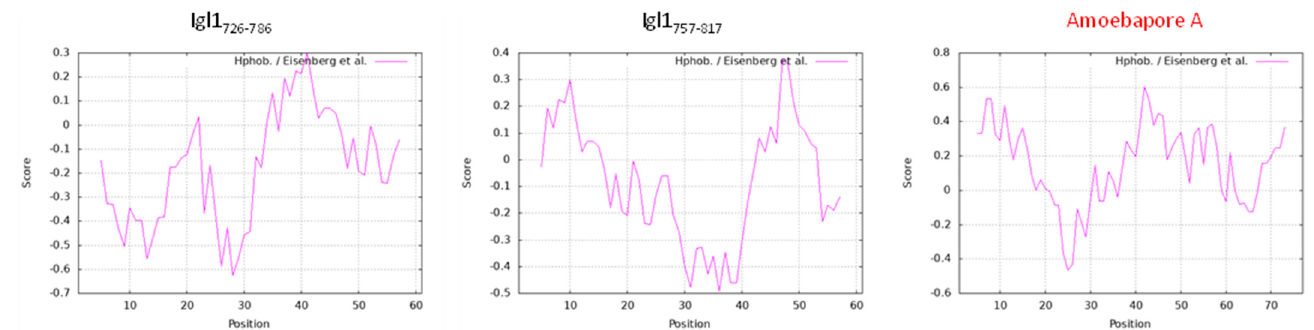
Figure 7. Hydrophobicity of Igl1 fragments and amoebapore-A. Hydrophobicity of Igl1 fragments and amoebapore-A (PDB: 1OF9_A) was calculated by ProtScale program in Expasy (https://web.expasy.org/protscale/) (accessed on 6 July 2022) with an amino acid scale published by Eisenberg et al. [20]. Igl1 fragments in red or black indicate the fragments with or without hemolytic activity, respectively.